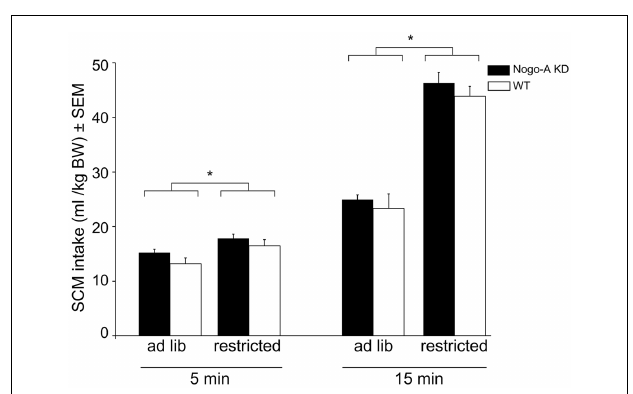
FIGURE 1 | Reward sensitivity in Nogo-A deficient rats .There were no differences in SCM intake between Nogo-A KD andWT rats under any feeding condition or at any time point. Restricted feeding prior to the consumption test resulted in higher SCM intake after 5min ( p < 0.001) and 15min ( p < 0.001). Data are expressed as means ± SEM.WT: n = 8, Nogo-A KD: n = 9. Asterisks (*) indicate statistically significant